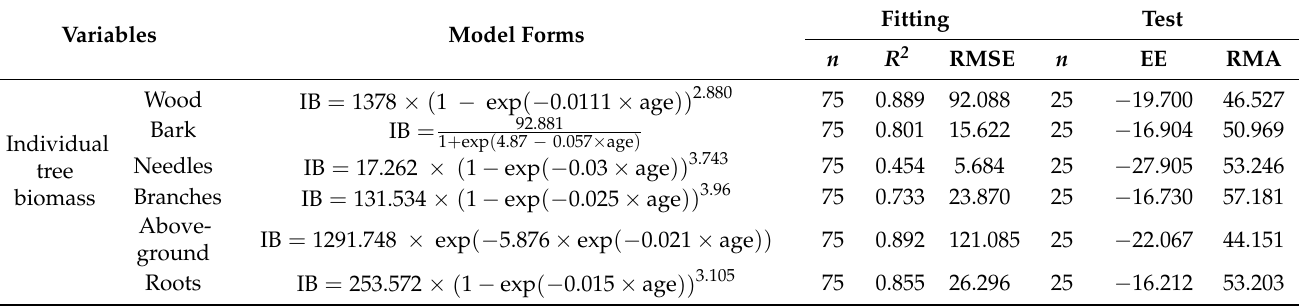
Table 8. The estimation result of the IB+SD. The IB is the individual tree biomass of each component (wood, bark, needles, branches), above-ground, and root tree biomass. The age is the tree